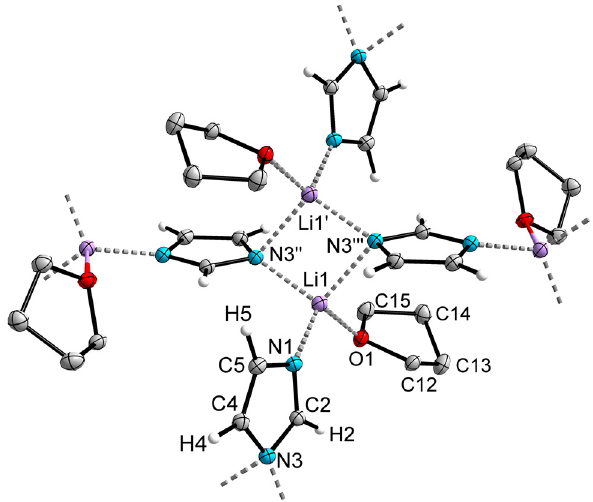
Table  : Data collection and handling.